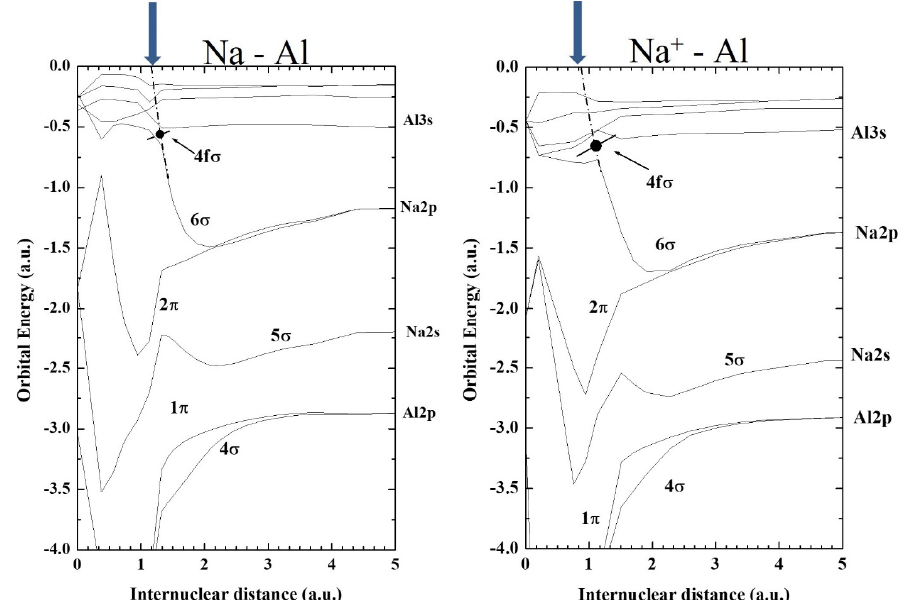
Figure 8. Adiabatic molecular-orbital (MO) correlation diagrams for the selected orbitals of Na-Al ( left ) and Na + -Al ( right ), as calculated by the DFT method [38]. The dashed-dotted heavy curve indicates the evolution of diabatic level up to the continuum. The arrows on top approximately indicate the threshold for promotion of the electrons in the 4f σ